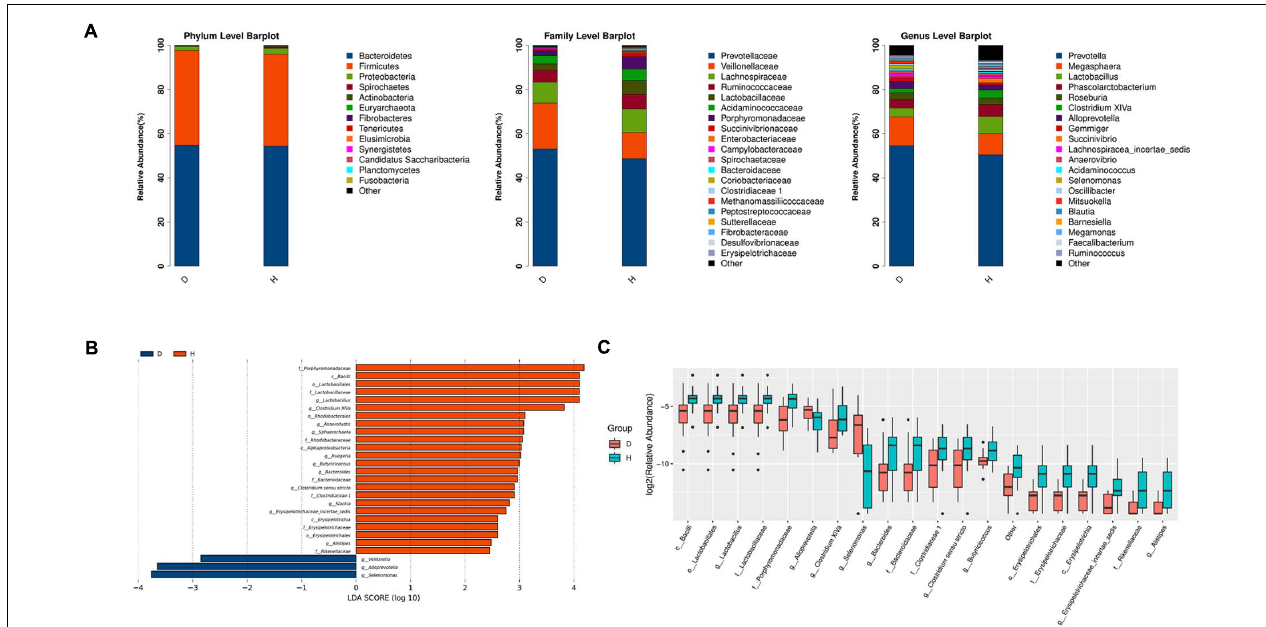
FIGURE 2 | Microbiota structure analysis of two groups. (A) According to the results of species annotation, the corresponding histogram of crop species profiling in phyla, family, and genus can be used to intuitively check the species with higher relative abundance and their proportion in different classification levels of each group. (B) LDA Effect Size (LEfSe analysis): LEfSe used linear discriminant analysis (LDA) to estimate the impact of the abundance of each component (species) on the difference effect and to identify the community or species that had a significant impact on the sample division (The LDA threshold is 2). (C) Boxplot result of genus level differential species. (D, Diarrhea; H,